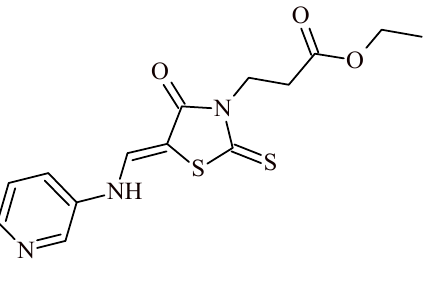
Figure 44. The structure of ethyl 3-[4-oxo-5-[(3-pyridylamino)methylene]-2-thioxothiazolidin-3- yl]propanoate ( 102 ).